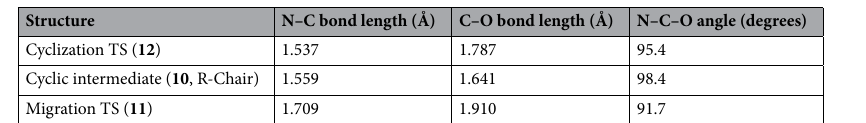
Table 1. Calculated bond lengths (in Å) and bond angles (°) in the cyclization and migration transition structures (TSs).